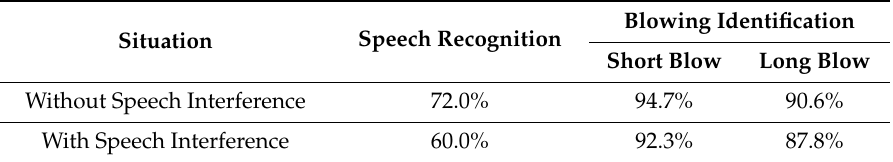
Table 3. Comparison of identification rates.